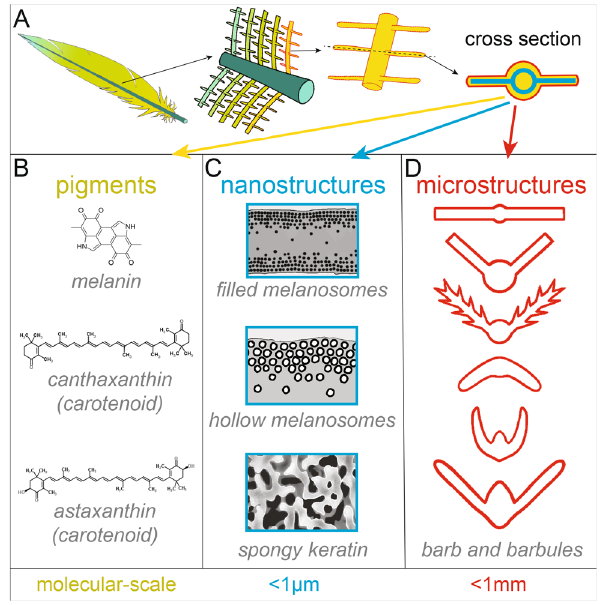
Figure 8. Feather color is produced by three interacting features: pigments, nanostructures, and microstructures. This schematic is a simplified illustration of the major physical causes of feather color; plumages are immensely variable. ( A ) From left to right, we show (i) a feather, (ii) a zoomed-in view of the rachis, barb, and barbules; (iii) the barb and barbules; (iv) an idealized cross section of the central barb and barbules. ( B ) At the molecular scale, pigments such as melanin, canthaxanthin, and astaxanthin produce colors 22,114,115 . ( C ) At the sub-micrometer scale (< 1 µm), nanostructures 116 such as filled melanosomes 33 , hollow melanosomes 34 , and spongy keratin matrices 35 produce iridescent colors and blue colors. ( D ) Between 1 µm and 1 mm, microstructures of the barb and barbules affect pigment saturation, gloss, and brightness 23–31 . All illustrations in this figure are by A.